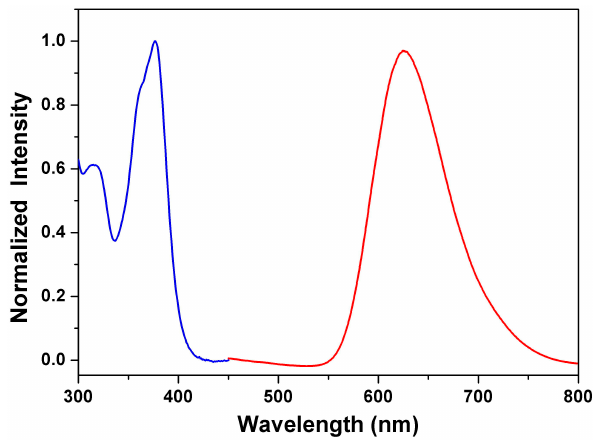
Figure 3. Normalized absorption (blue line) and emission (red line) spectra of 1 in cyclohexane.